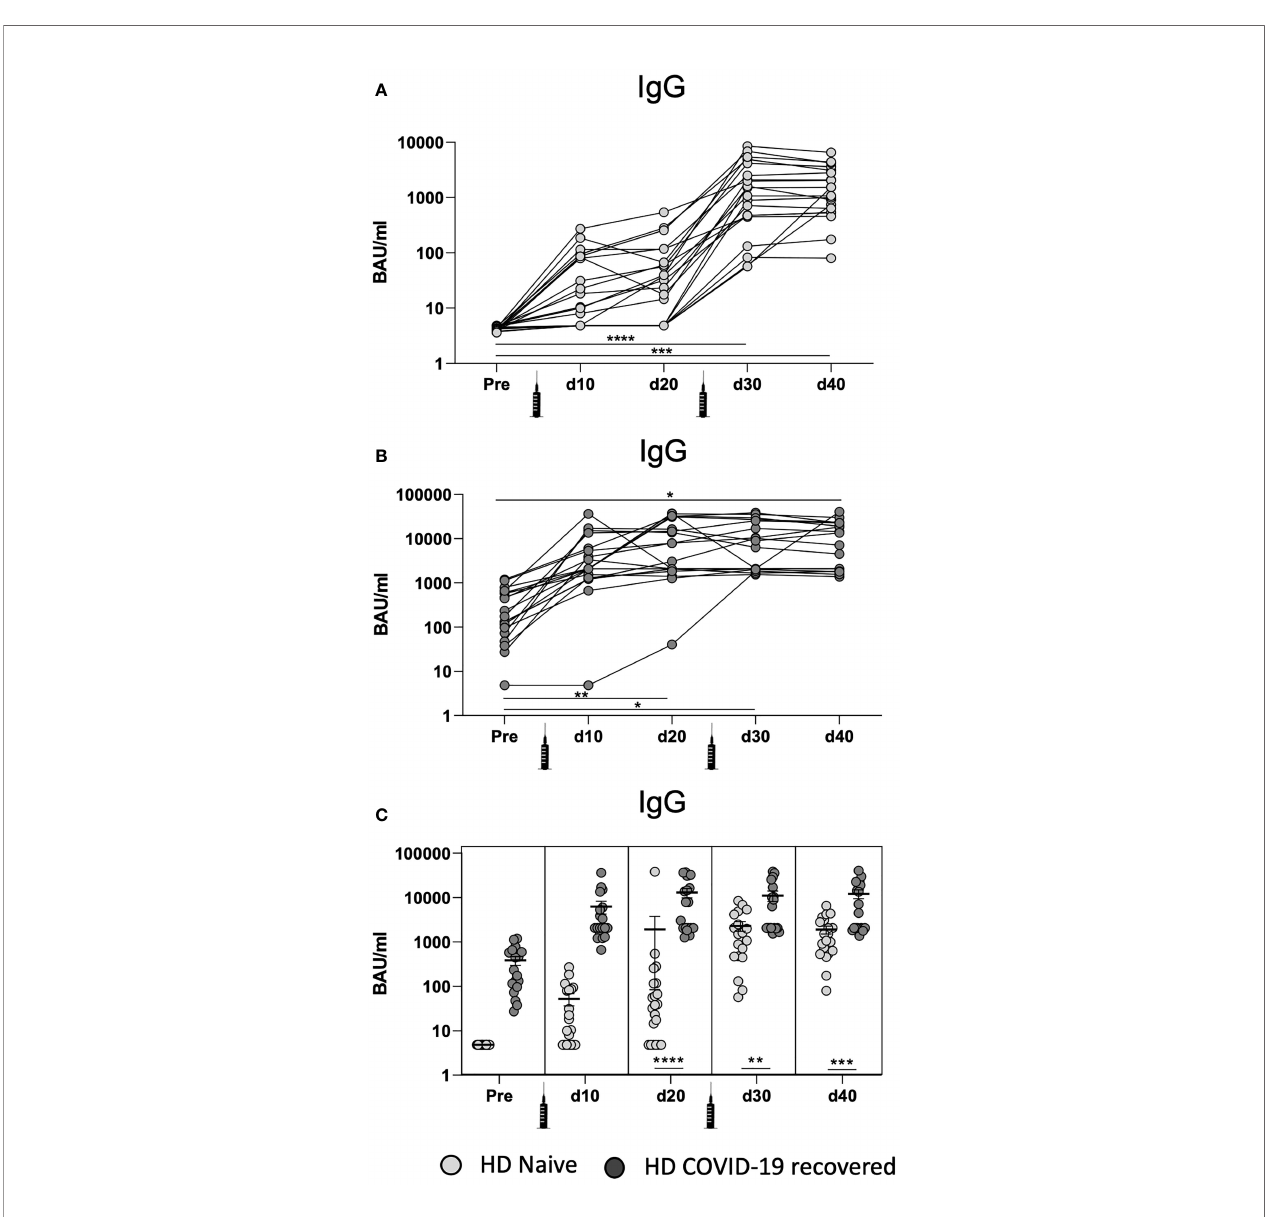
FIGURE 2 | Development of humoral responses after mRNA-1273 vaccination in COVID-19 recovered and naïve HD patients. (A) Quanti fi cation of SARS-CoV-2 spike-speci fi c IgG serum levels in naive HD patients at different time points: before vaccination (pre), after the fi rst (d10 and d20) and second (d30 and d40) mRNA vaccine dose. (B) Quanti fi cation of SARS-CoV-2 spike-speci fi c IgG serum levels in COVID-19 recovered HD patients at different time points. (C) Comparison of SARS-CoV-2 spike-speci fi c IgG serum levels in naïve and COVID-19 recovered HD patients. Samples were measured with Liaison ® SARS-CoV-2 TrimetricS IgG assay. Values higher than 33.8 BAU/ml were considered positive. * <0.05, ** <0.005, *** <0.0005, ****